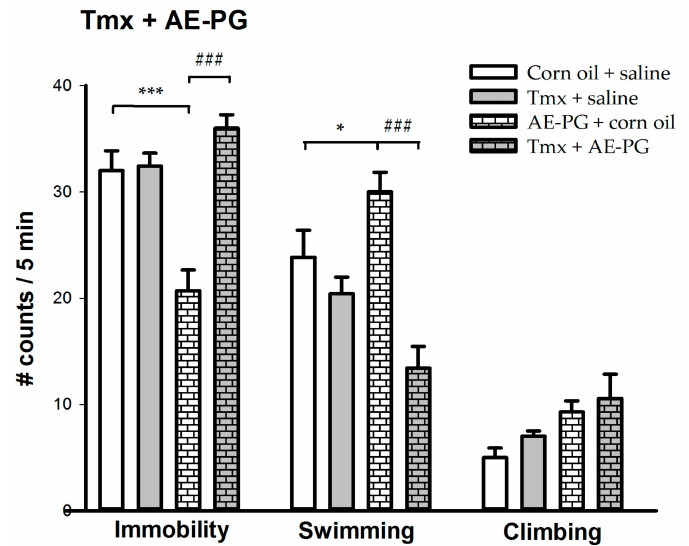
Figure 2. Behavioral effects of the chronic administration (14 days; one administration per day) of the minimum effective dose of the AE-PG (1.0 mg/kg) with Tmx (15 mg/kg) on the forced swimming